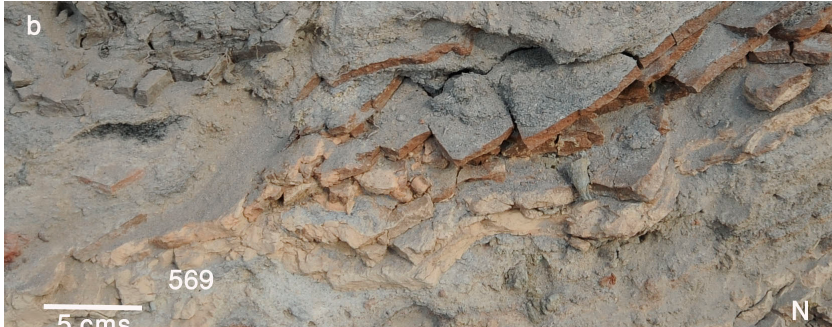
Figure 2. ( a ) Photograph of the layer of sherds in the firing chamber. The layer is embedded in grey sediment that is rich in melted phytoliths, cristobalite, and small amounts of highly disordered calcite [15]. The numbers show the locations of the samples analyzed. ( b ) Higher magnification view of the central part of the sherd layer showing the transition from dark brittle sherds in the north to light tan colored friable sherds further south. The location of sample 569 is shown.